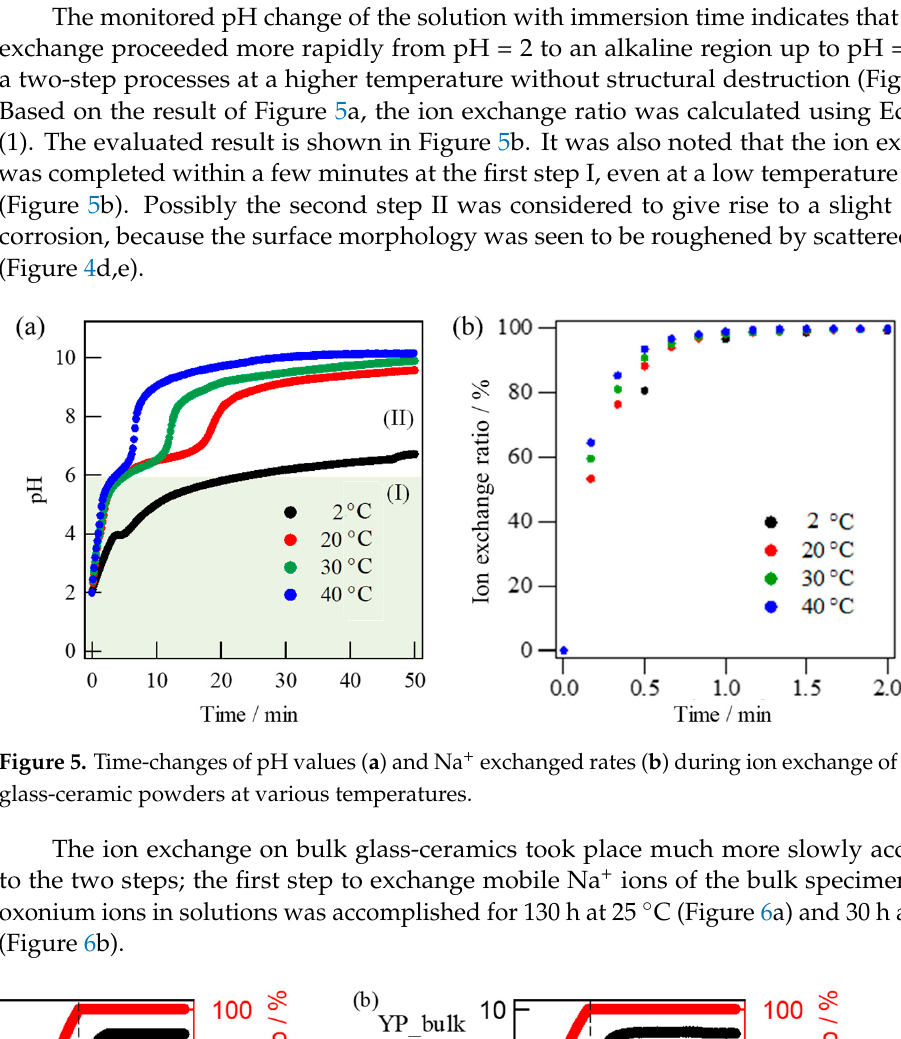
Figure 4. XRD patterns ( a ); SEM photographs of starting ( b ); ion exchanged Narpsio glass-ceramics in 0.03 M ( c ); 0.1 M ( d ); 1.0 M HCl aqueous solutions ( e ). The red solid circles in Figure 4a denote